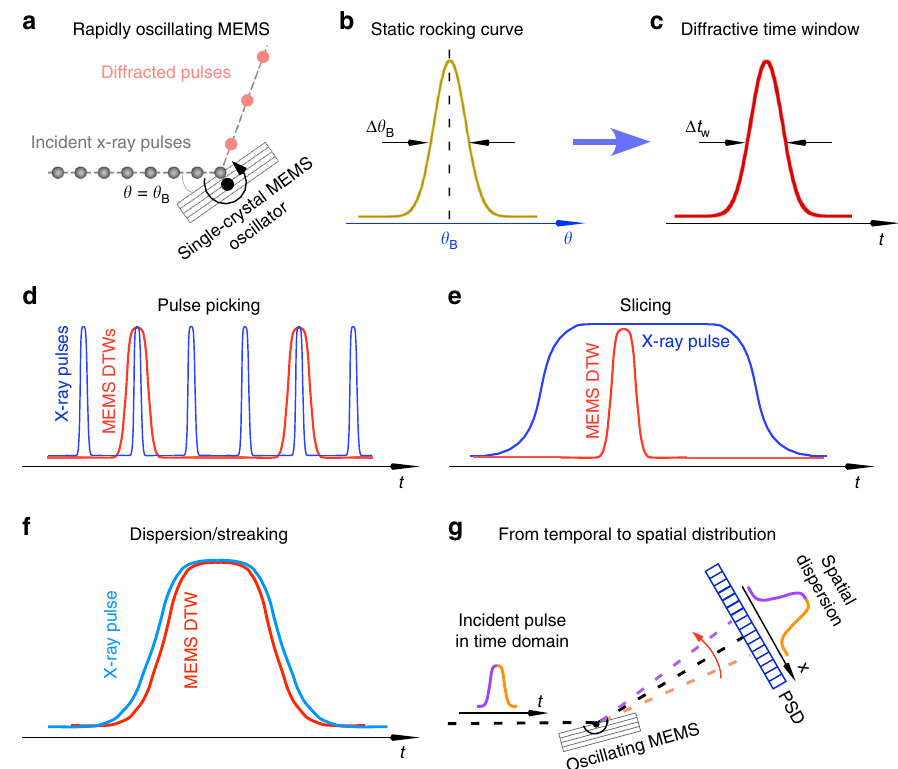
Fig. 1 Manipulation of hard X-ray pulses using a microelectromechanical-system (MEMS)-based oscillator. a Schematic of a rapidly oscillating single- crystal micromirror in a torsional MEMS device that diffracts monochromatic X-rays at its Bragg angle. b Static crystal rocking curve around Bragg angle θ B with a full-width-at-half-maximum (FWHM) of Δ θ B , typically several milli-degrees. c Around the instance that the single-crystal element rotates through the Bragg angle, the crystal rocking curve converts to a temporally dispersed diffractive time window (DTW) with a FWHM of Δ t w . d When the DTW width is much wider than the X-ray pulse, but narrower than the pulse-to-pulse spacing, the MEMS can be utilized as an ultrafast pulse-picking device. e When the DTW is narrower than the X-ray pulse, the device creates X-ray pulses shorter than the incident pulse width in a form of pulse slicing in the time domain. f Dispersion/streaking of the X-ray pulse is possible, when the MEMS DTW is close to the incoming pulse width. g In the dispersion/ streaking mode using a position-sensitive detector (PSD), the oscillating MEMS converts the X-ray pulse in the time domain to a spatially dispersed signal that contains time-resolved, sub-pulse